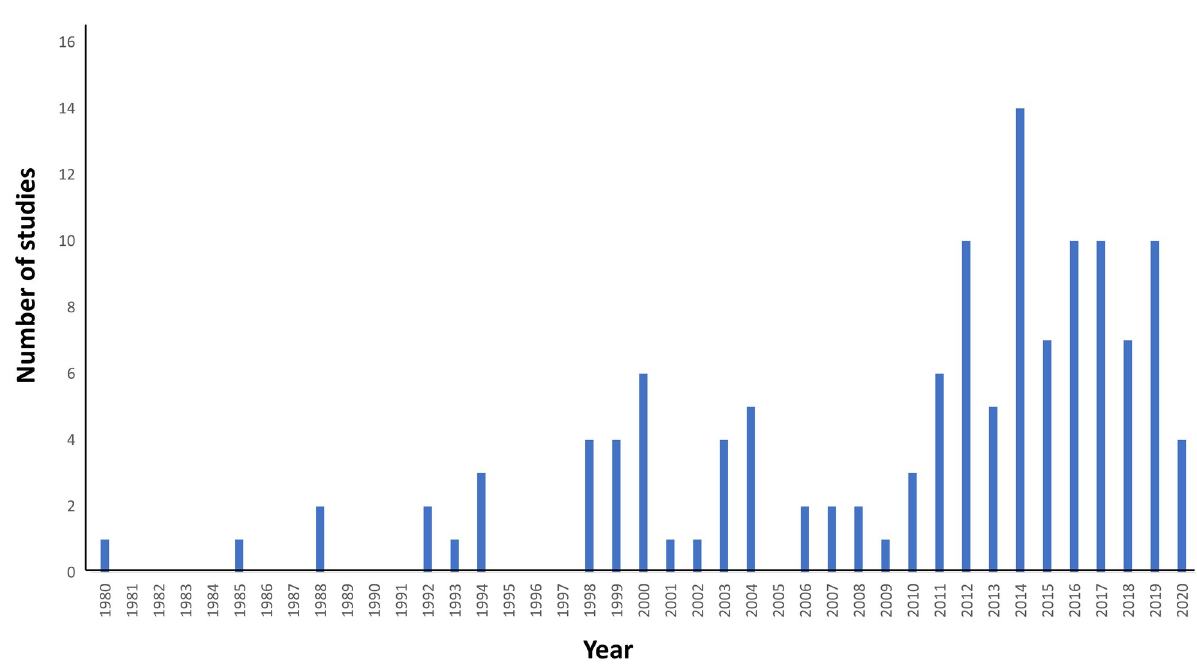
Fig 3. Distribution of publication year for the included papers (n = 128).